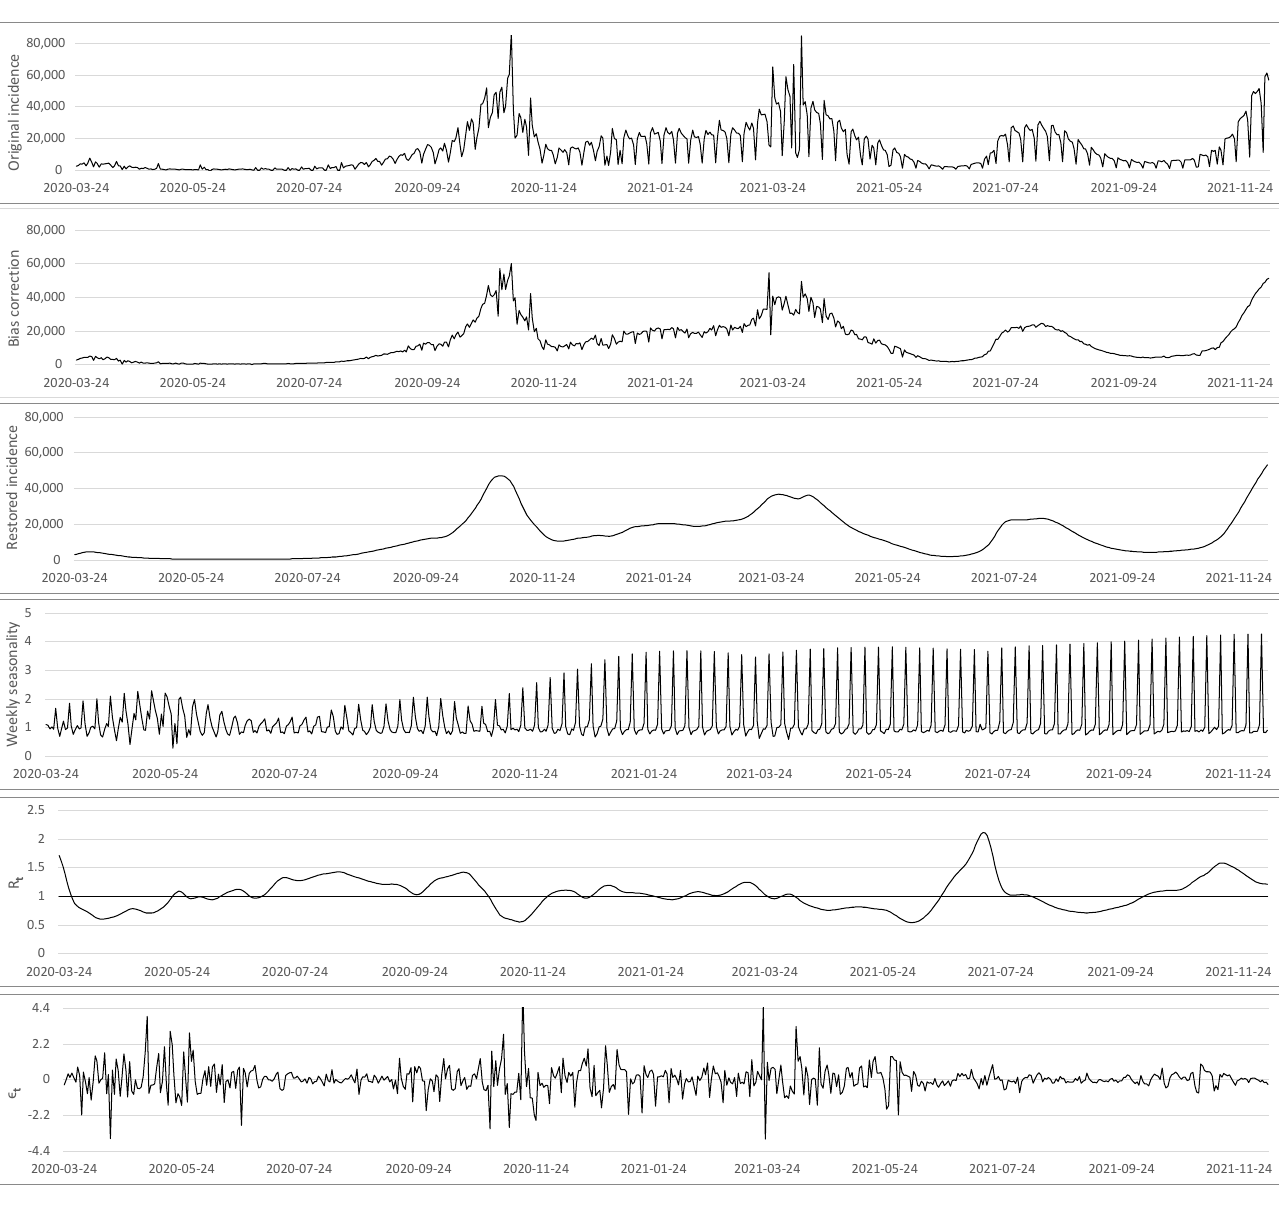
of France, (ii) the incidence curve t , (iv) the weekly t